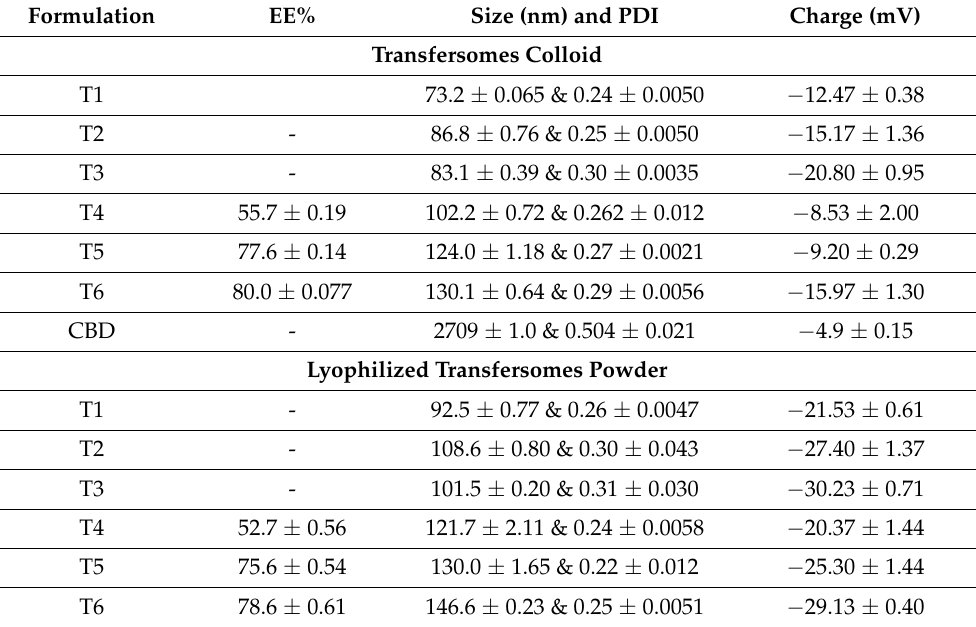
Table 2. Micomeritic and stability characterization of the CBD-loaded